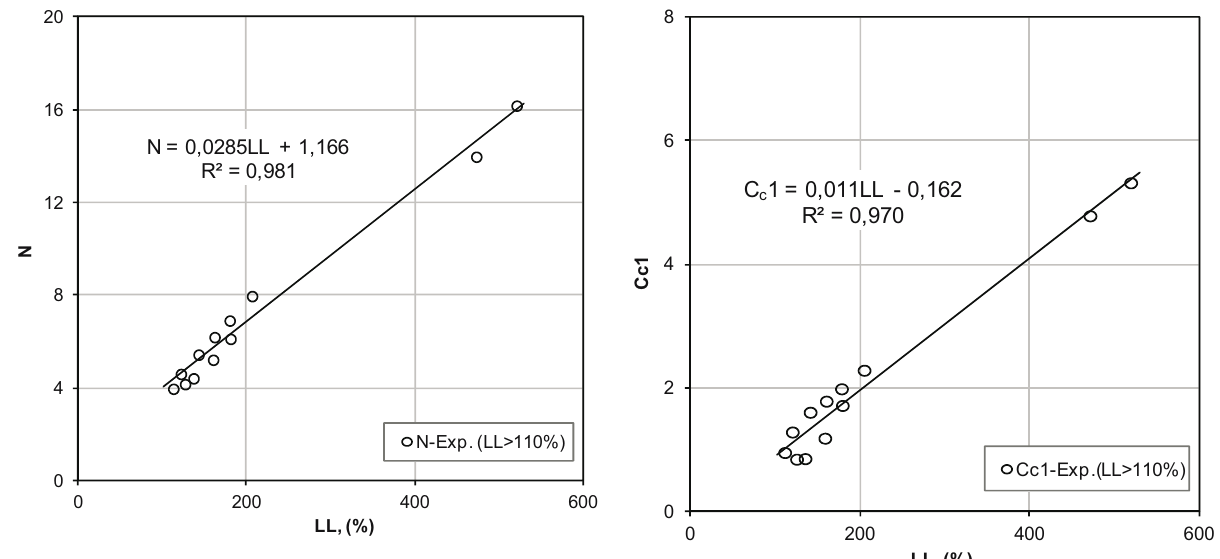
Figure 7: Best - fi t relationship of N vs LL > 110% ( 12 di ff erent soils ) .